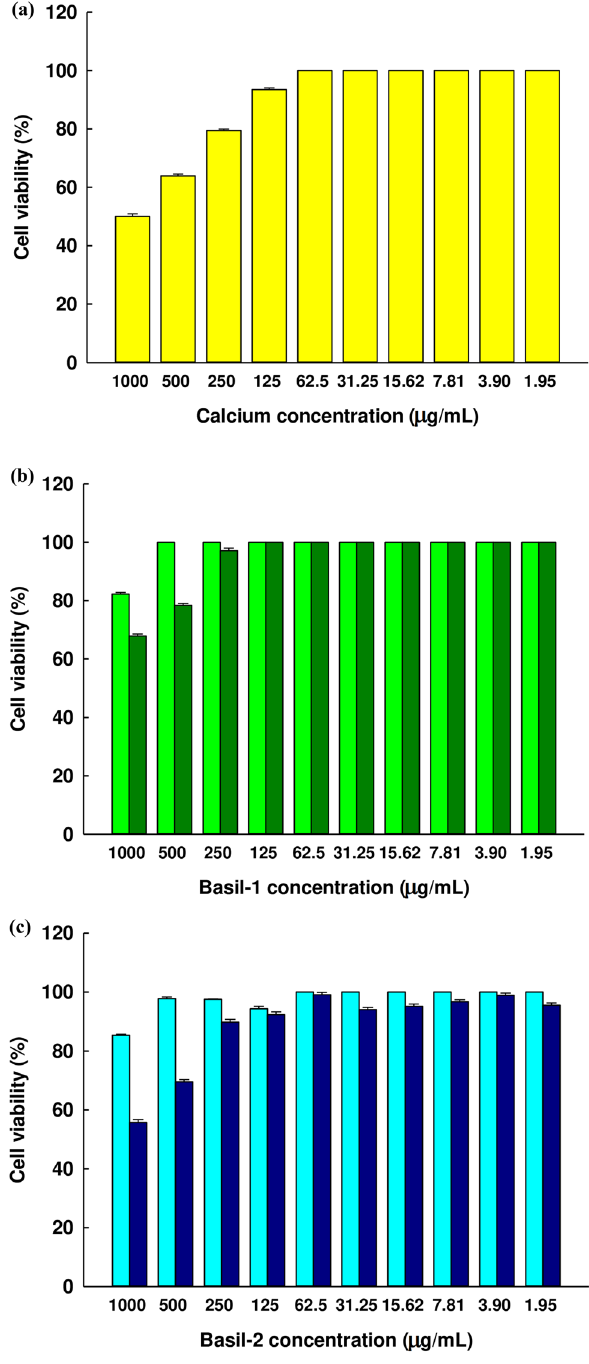
Figure 5. The viability of the Caco-2 cells following treatment at varying concentrations of ( a ) CaCl 2 solution ( ), ( b ) Basil-1 ( ) and Basil-1-calcium complex ( ), and ( c ) Basil-2 ( ) and Basil-2-calcium complex ( ) The graph shows the mean ± SE (n =